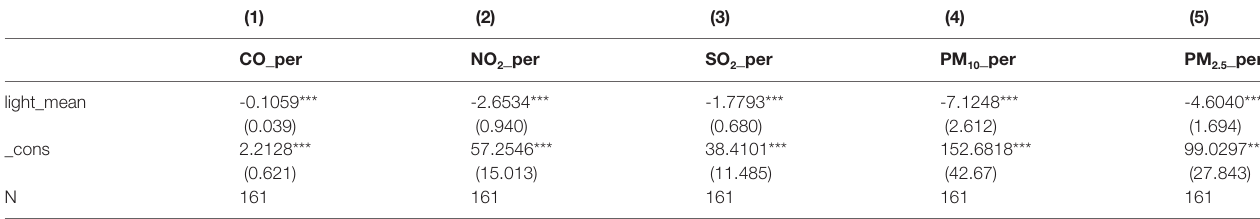
TABLE 5 | The impact of economic development on air pollutants intensity without control